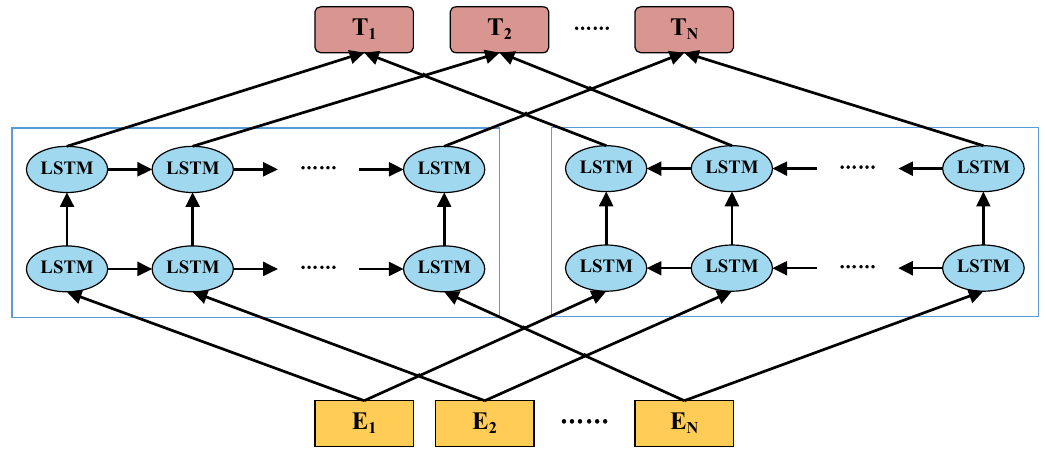
Figure 2. Structure of ELMo.